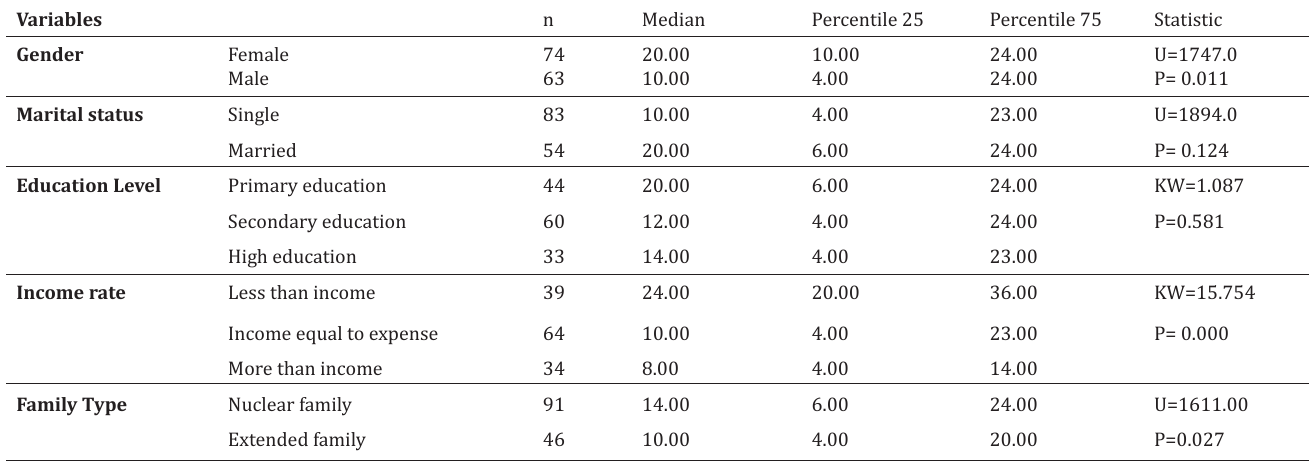
The results are expressed as median and percentiles. Comparison of the Demographic Characteristics of the Individuals and Beck Anxiety Inventory